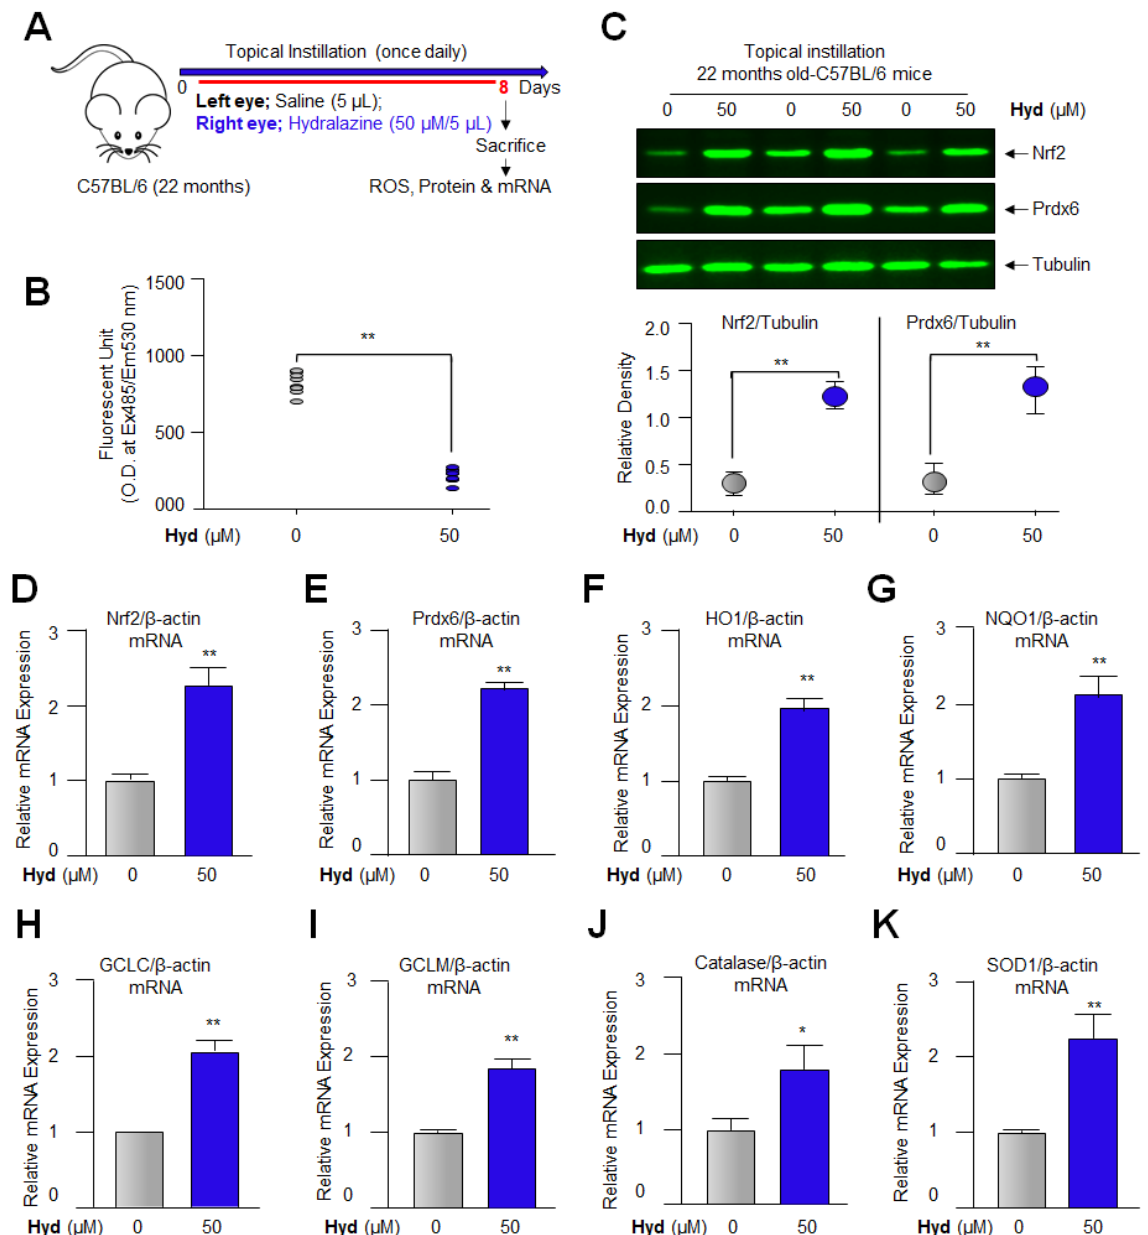
Figure 11. Topically instilled, Hyd enhanced expression of Nrf2 and antioxidant genes in aged mouse eye in vivo. ( A ) 22 M old C57BL/6 mice (each group; n = 6, 12 lenses) were used for the experiment. Hyd or buffered saline was instilled topically once daily for 7 days as follows: Vehicle control (left eye, buffered saline) and Hyd (right eye, 50 µM/5 µL in each eye). ( B ) On day 8, animals were sacrificed, and lenses were isolated and subjected to ROS quantitation using H 2 -DCF-DA dye method. The data represent as the mean ± S.D. values derived from three independent experiments. Control vs. Hyd treated, ** p < 0.001. ( C ) On day 8, animals were sacrificed, and total protein was isolated from lenses and subjected to Western blot analysis. Hyd enhanced the protein expression of Nrf2 and its target gene Prdx6. Tubulin was used as an internal control. Protein bands were quantified using densitometer, and levels were normalized with corresponding tubulin band intensity level. The relative density was presented in the form of histograms below the protein blots. ** p < 0.001. ( D – K ) Total RNA was isolated from the buffered saline or Hyd treated eye lenses in vivo and processed for RT-qPCR analysis. Results revealed that Hyd upregulated mRNA expression of Nrf2 ( D ) and Nrf2 target antioxidant genes ( E – K ). All histograms are presented as mean ± S.D. values obtained from three independent experiments. Control vs. Hyd treated, * p < 0.05; ** p < 0.001.